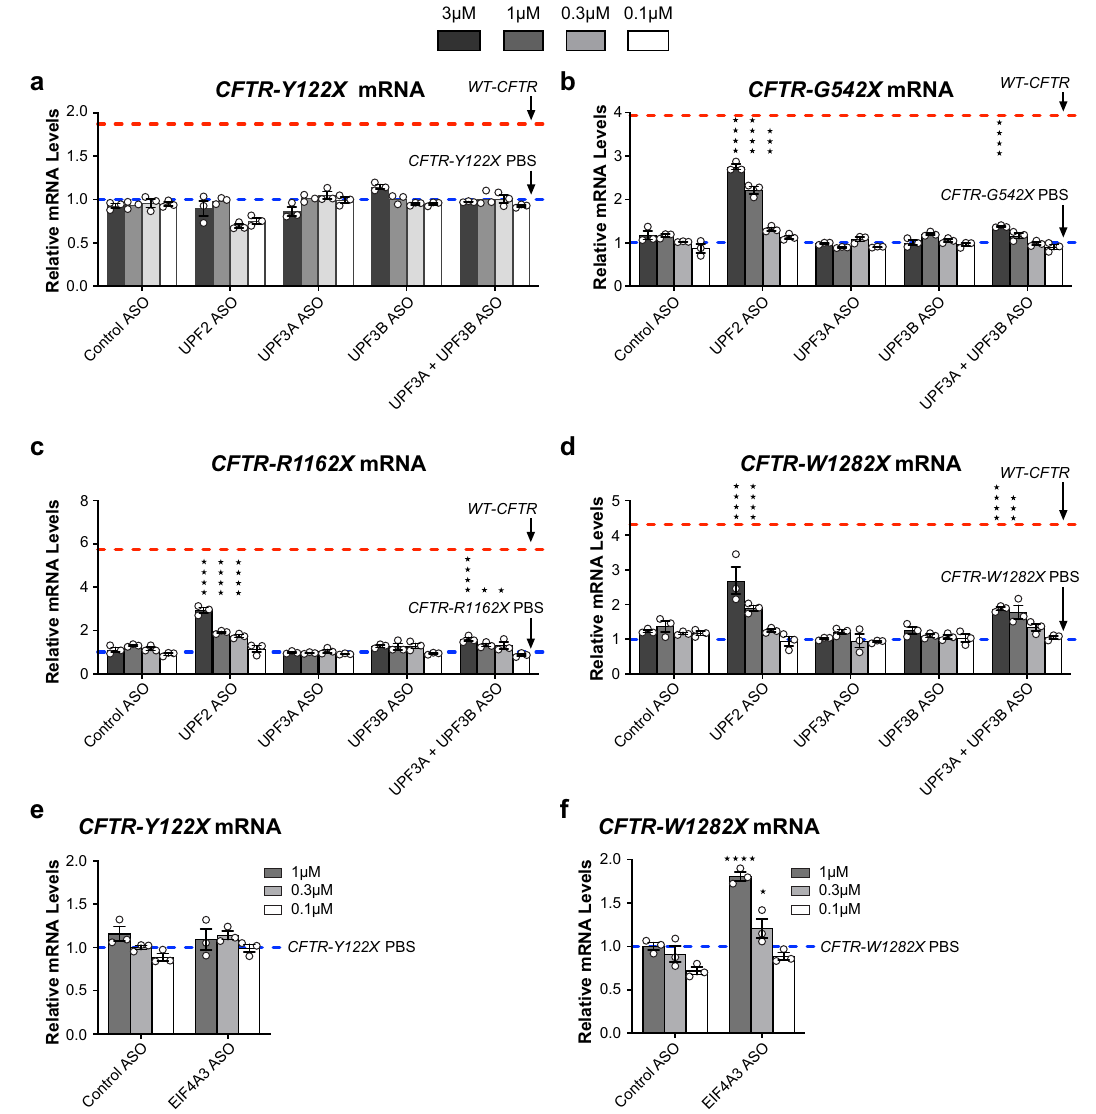
Fig. 4 CFTR mRNAs with nonsense codons G542X, R1162X, and W1282X, but not Y122X, are recognized by UPF2 and UPF3 paralogs. RT-qPCR analysis of CFF-16HBEge cells with ( a ) Y122X, ( b ) G542X, ( c ), R1162X, or ( d ) W1282X CFTR nonsense mutations treated with ASOs targeting UPF2 , UPF3A , or UPF3B . RT-qPCR analysis of CFF-16HBEge cells with ( e ) Y122X or ( f ) W1282X CFTR nonsense mutations treated with ASO targeting eIF4A3 . Cells treated with PBS or a scrambled control ASO were used as negative controls. CFTR mRNA levels were normalized to total RNA levels. CFTR mRNA levels were also normalized to housekeeping gene β -actin mRNA (Supplementary Fig. 5). PBS control levels were set to 1 and are indicated by blue dotted lines. Wild-type (WT) CFTR mRNA levels from parental cells are indicated by red dotted lines. n = 3 for each group. Data are presented as mean ± SEM from biologically independent samples. Statistical signi fi cance was analyzed by two-way ANOVA followed by Dunnett ’ s multiple-comparison test (* p < 0.05, *** p < 0.001, **** p < 0.0001). See Source Data fi le for the exact p -values. Source data are provided as a Source Data fi